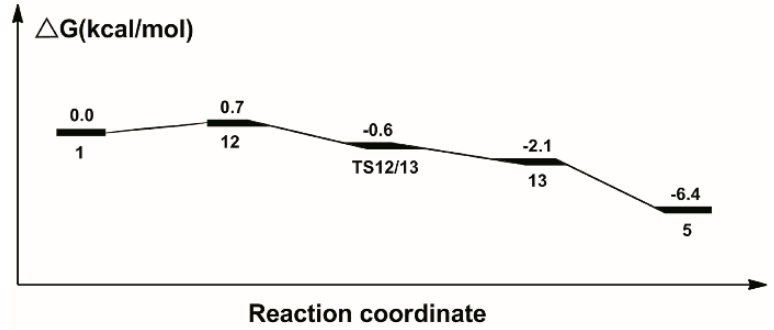
Figure 7. Free energy profile for the hydrogenation of formaldehyde to methanol.